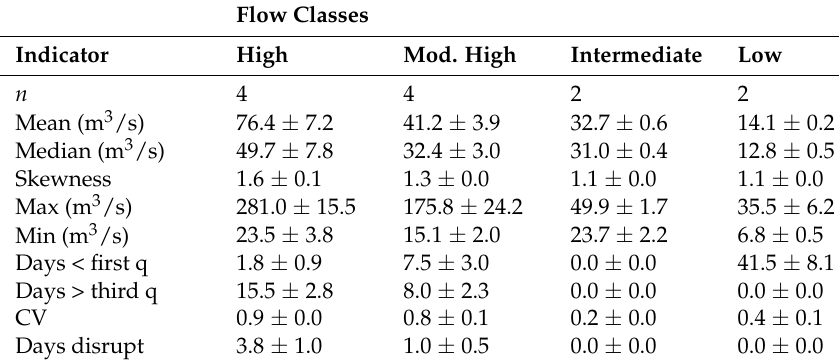
Table 1. Summarized characteristics of hydrological indicators of each flow class (average ± standard error). Note that mean, median, and maximum discharge were not used for classification to avoid